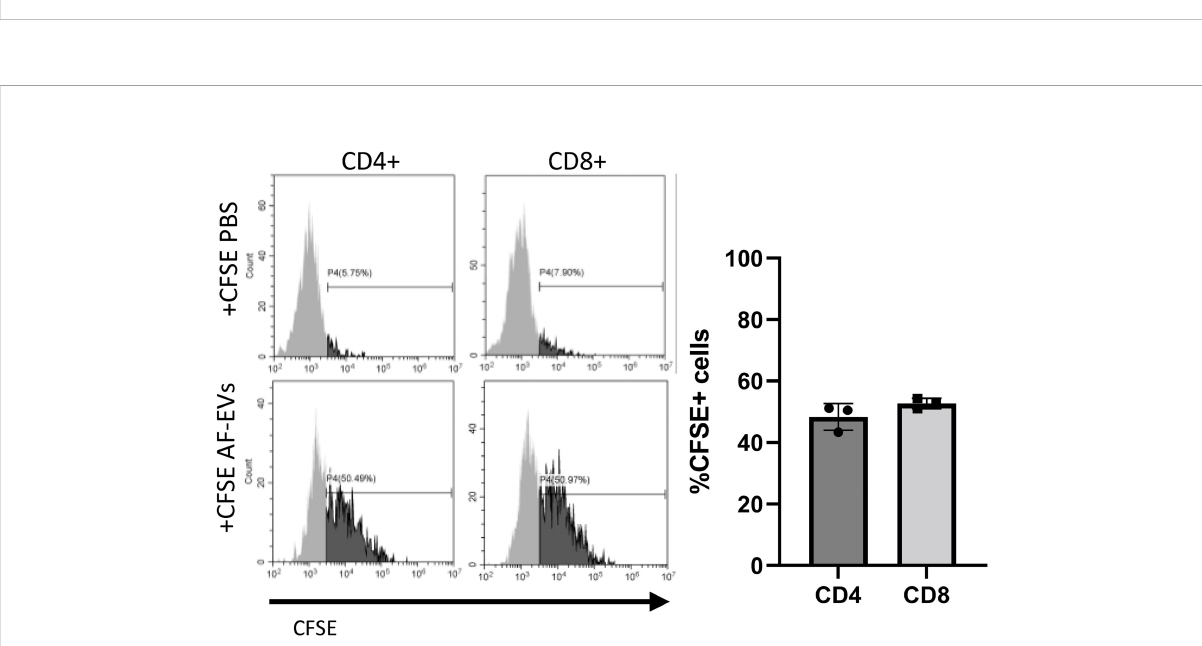
FIGURE 7 AF-EV uptake in T effector cells. Representative histograms and graphed percentages of CFSE labeled cells within each cell population. CFSE labeled cells were analyzed after 3 days of culture with CFSE EVs (Data graphed as mean ± SD; n=3 for each group; Each experiment used 1 independent PBMC donor treated with 1 of 3 AF-EV